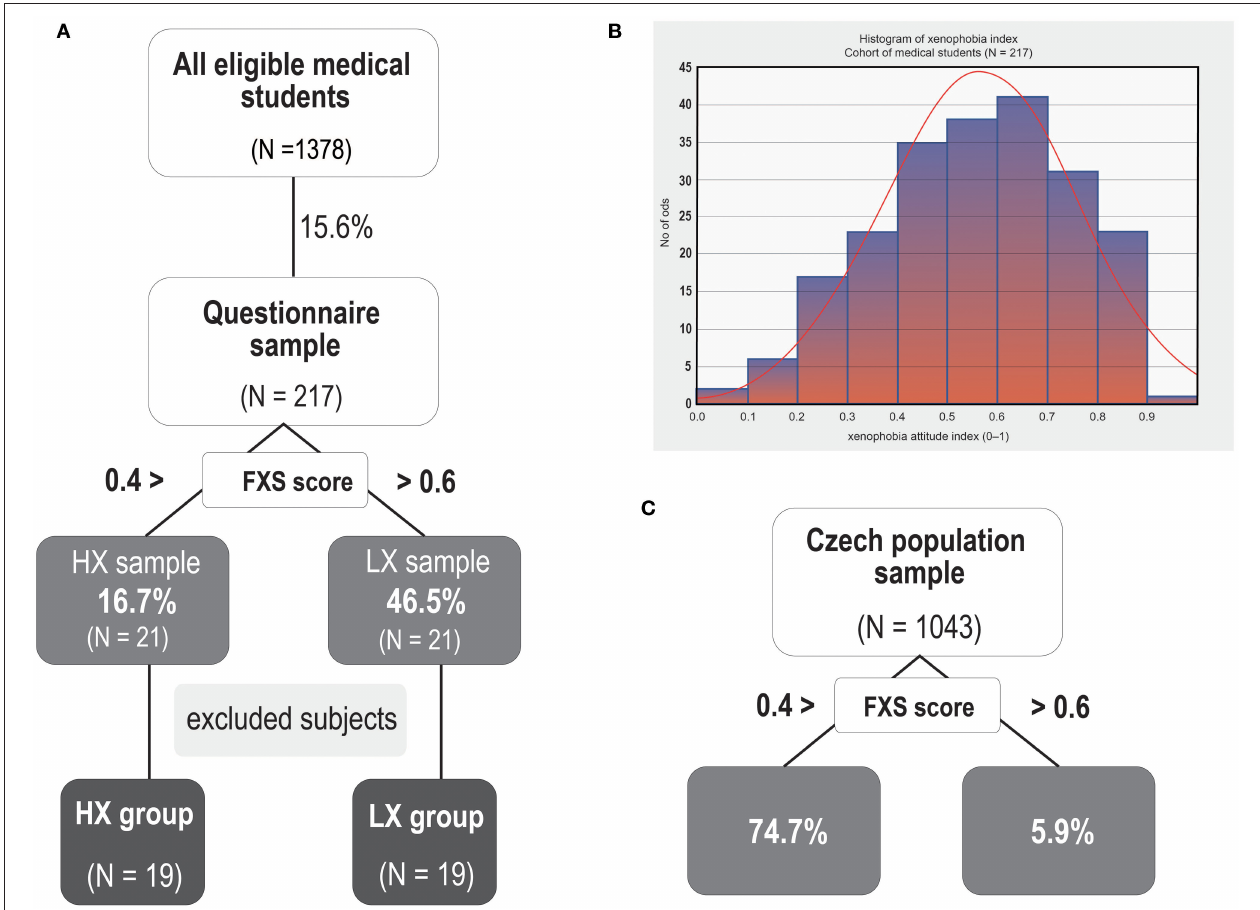
FIGURE 1 | Profile of the experimental sample. (A) Experimental sample distribution and illustration of the recruitment process. (B) Histogram depicting the distribution of results for the Fear-Based Xenophobia (FXS) Scale (a total score ranging from 0 to 1) in the sample of 217 subjects who filled in the short online questionnaire. (C) Distribution of the two opposite poles of FXS scores in the selected sample of the Czech population. Note that when compared to a representative sample of the Czech general population, our participants showed substantially lower levels of xenophobia [with both a lower rate of high xenophobia scores (below 0.4) and a higher rate of the least xenophobic scores (0.6–1) (see % values in diagram A,B )]. Note that the threshold values are different from the stricter inclusion criteria that were applied in the recruitment process (below 0.25 or above